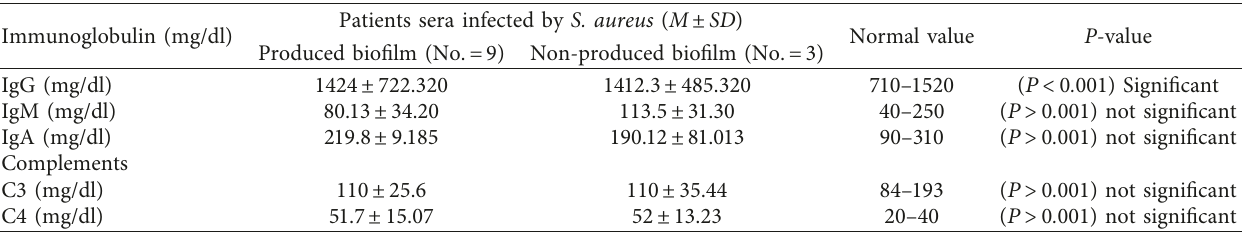
Table 6: Complement levels and immunoglobulin mean values in patients’ sera with S. aureus (formed and non-formed biofilms) infection. Patients sera infected by S. aureus ( M ± SD ) Immunoglobulin (mg/dl) Normal value P -value Produced biofilm (No. � 9) Non-produced biofilm (No. �